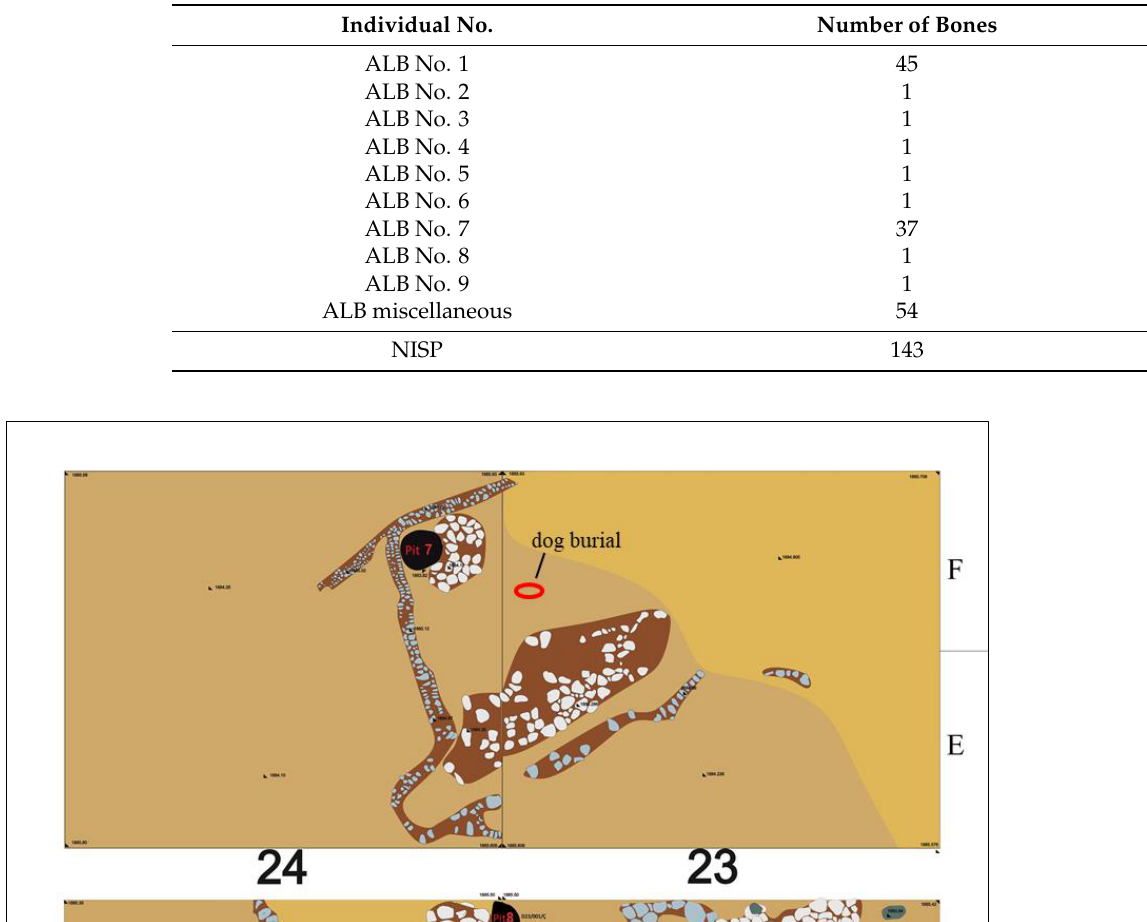
Table 3. Distribution of individuals identified from the assemblage.